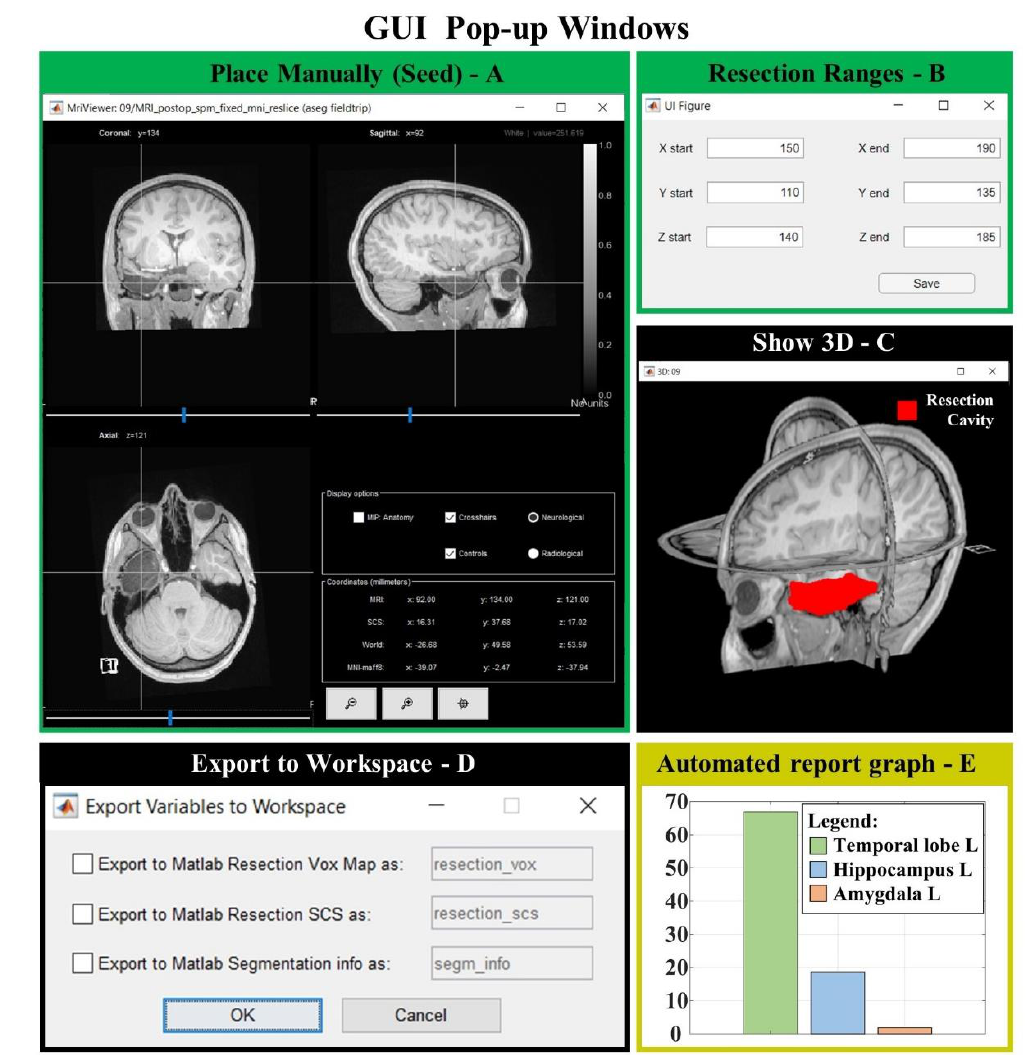
Figure 8. GUI popup windows. ( A ) MRI viewer for seed placement (when “Place Manually” is clicked). ( B ) Window for the definition of an optional ROI in which the region is free to grow (when “Change Ranges” button is clicked). ( C ) 3D MRI viewer from Brainstorm software (if “Show 3D” button is clicked) shows the 3D resection output (red). ( D ) If “Export to Workspace” is clicked, the user can export the output in voxel coordinates and/or in Subject Coordinates System (SCS), as well as the segmentation parameters and seed coordinates (Segmentation info). ( E ) Bar graph of the anatomical report (when “Generate automated report graphs” is selected).